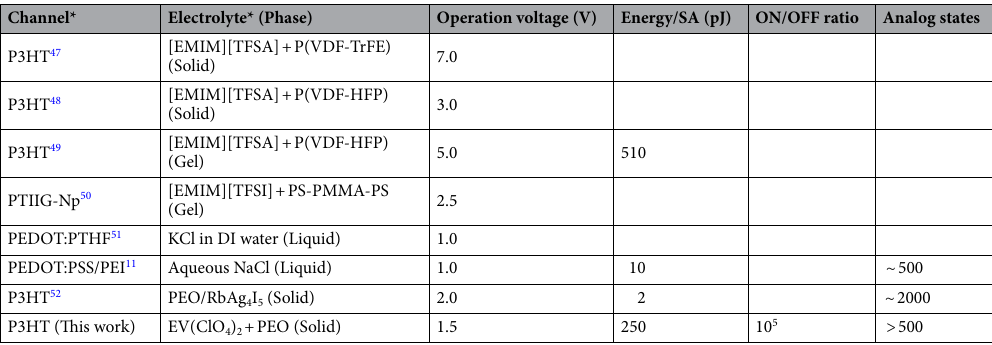
Table 1. Performance comparison of the fabricated mem Ts with previously reported memory devices using electrolytes as the gate dielectric. *[EMI][TFSA/I] → 1-Ethyl-3-methylimidazolium bis(trifluoromethylsulfonyl) amide/imide, P(VDF-TrFE) → poly(vinylidene fluoride-co-trifluoroethylene), P(VDF-HFP) → poly(vinylidene fluoride-co-hexafluoropropylene), PTIIG-Np → poly(thienoisoindigo- alt-naphthalene), PMMA → polymethyl methacrylate, PS → polystyrene, PEDOT:PTHF → poly(3,4- ethylenedioxythiophene):poly(tetrahydrofuran), KCl → potassium chloride, NaCl → sodium chloride, PSS → poly(styrenesulfonate), PEI → polyethylenimine, RbAg 4 I 5 → rubidium silver